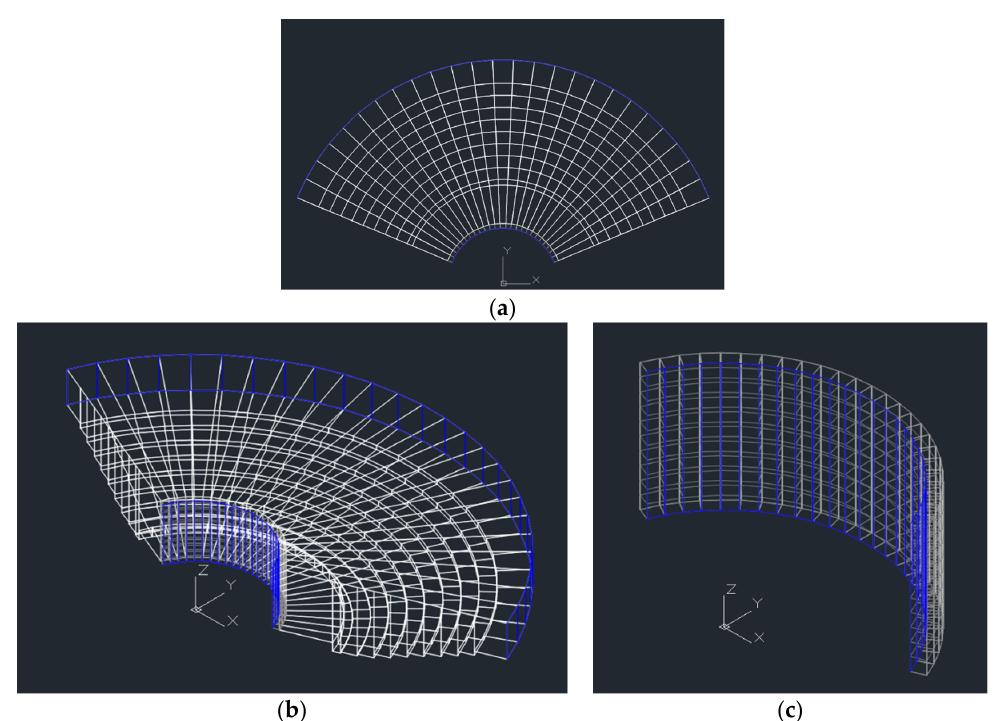
Figure 9. Virtual auditorium developed in Case A. ( a ) Top view of the auditorium and the semi- circular DSF, ( b ) tri-dimensional southeast view of the auditorium and the semi-circular DSF, and ( c ) tri-dimensional southeast view of the semi-circular DSF.